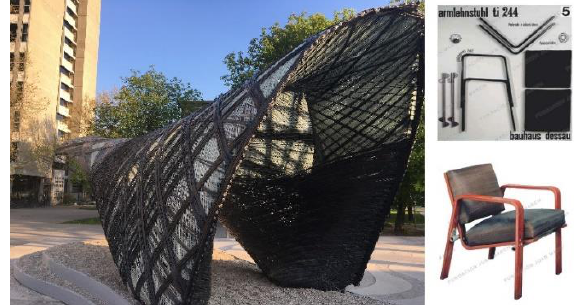
Figure 4. 1:1 scaled structure designed by ICD in 2017 (Photo by the author) and 1:1 scaled furniture design at Bauhaus (Albers, 2014).